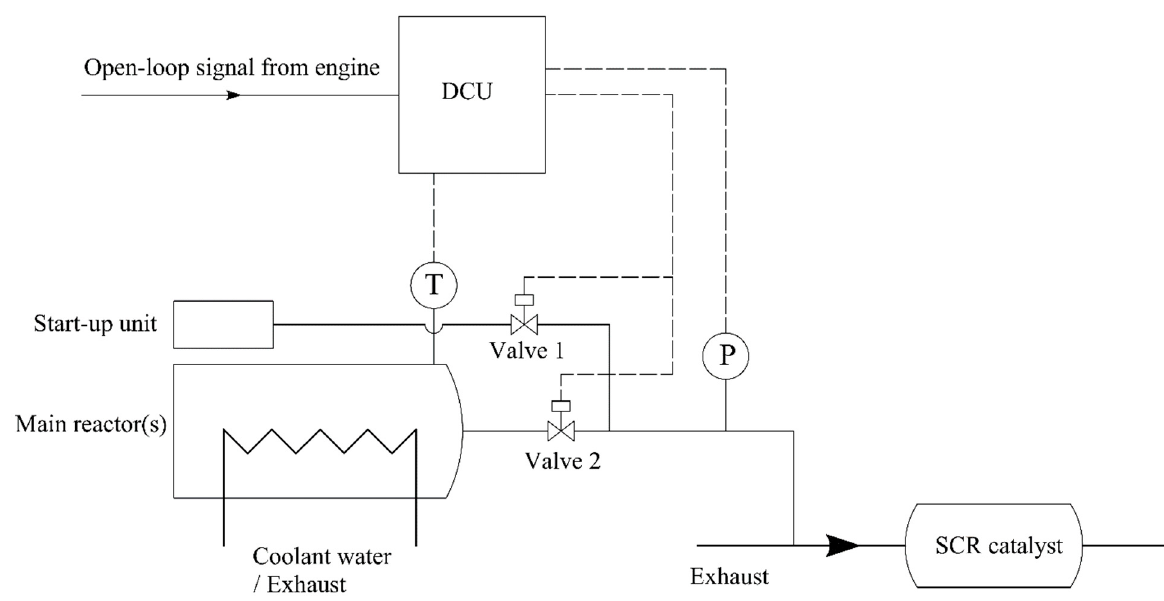
Figure 1. Schematics of sorption-SRC system with a start-up unit and main reactors.